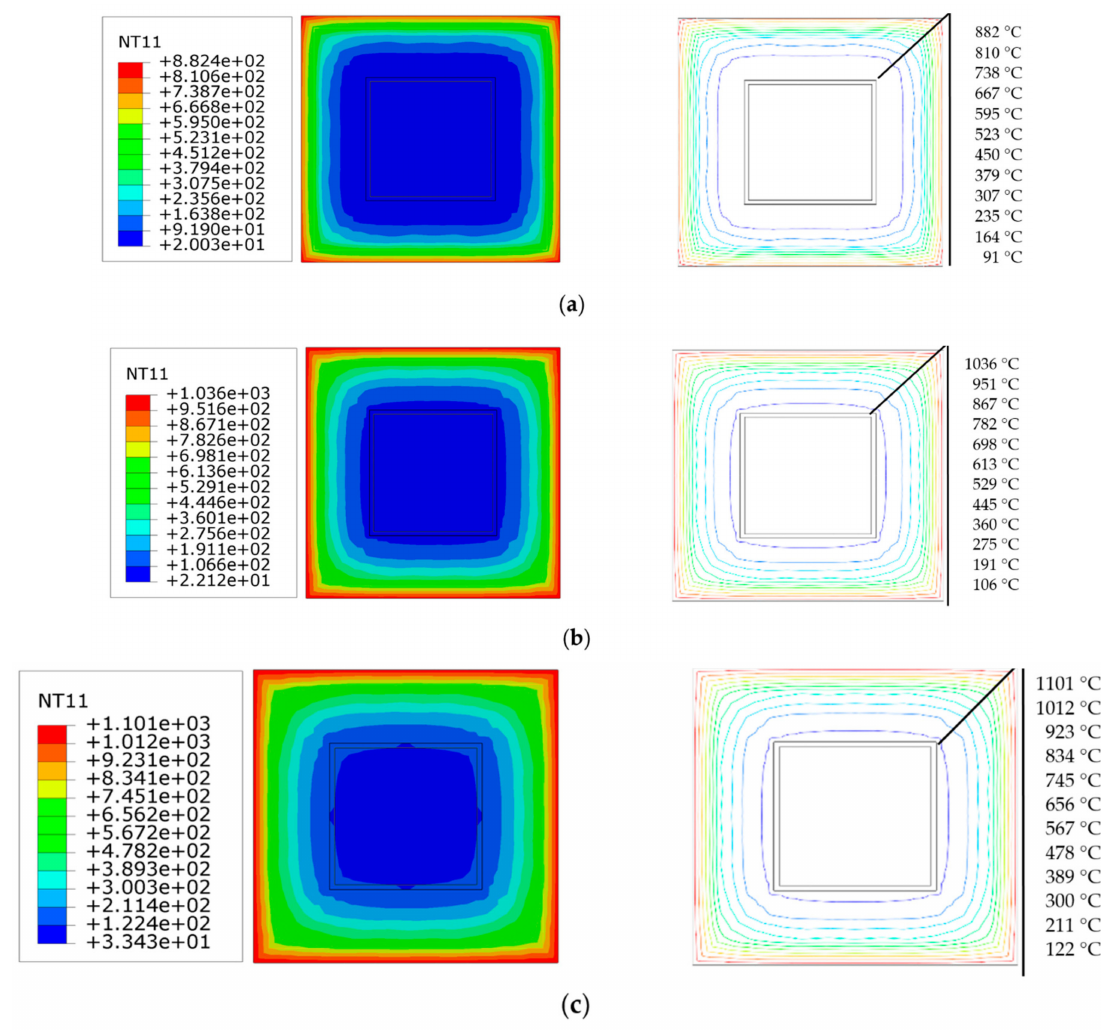
Figure 7. Temperature field distribution at different times ( a ) 60 min; ( b ) 120 min; ( c ) 180 min.